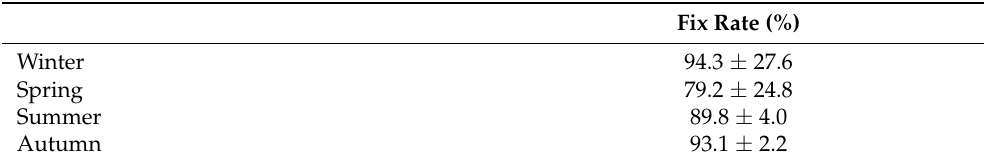
Table 3. Seasonal fix rate value (average ± s.d.) given by the ratio between the number of positions recorded and the scheduled number of fixes (480 positions every 24 h).